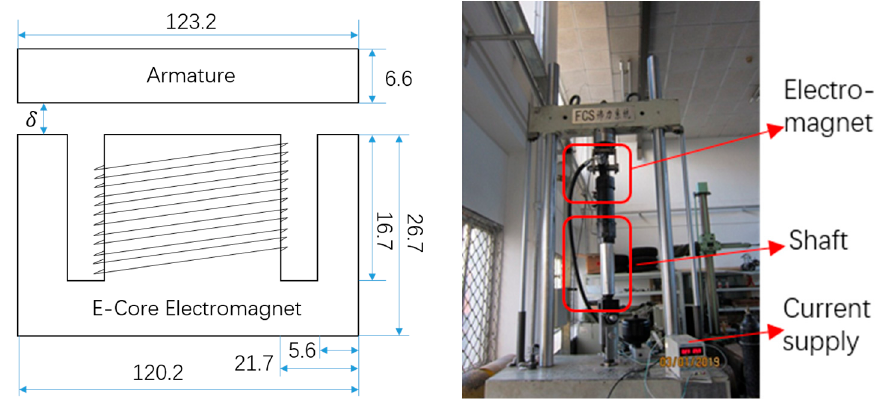
Figure 2. The experimental settings of electromagnetic force